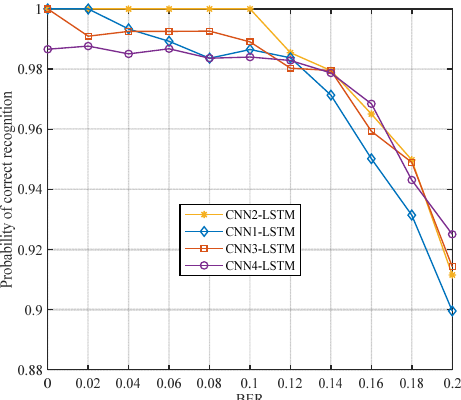
Figure 9. Effect of the number of CNN layers on the performance of the algorithm.